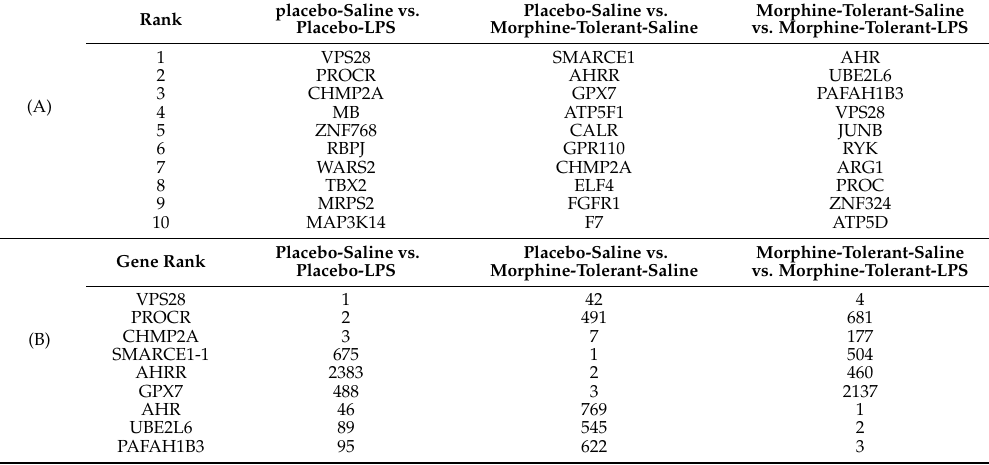
Table 4. LINCS Consensus Knockdown Connections from differentially expressed genes in the rat brain in response to lipopolysaccharides (LPS), with and without morphine tolerance. (A) Top 10 Consensus Knockdown Connections in the three sets of gene comparisons; (B) Rankings of the top three Consensus Knockdown Connections in the three sets of gene comparisons. Full name of the genes were provided in Table